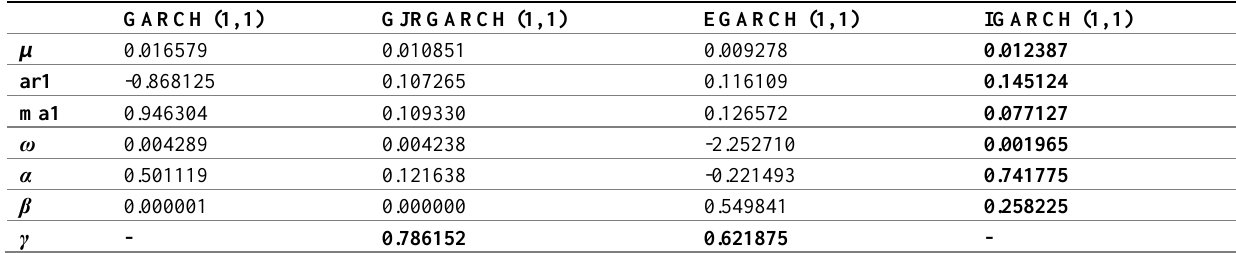
Table 1: Estimated parameters - normal